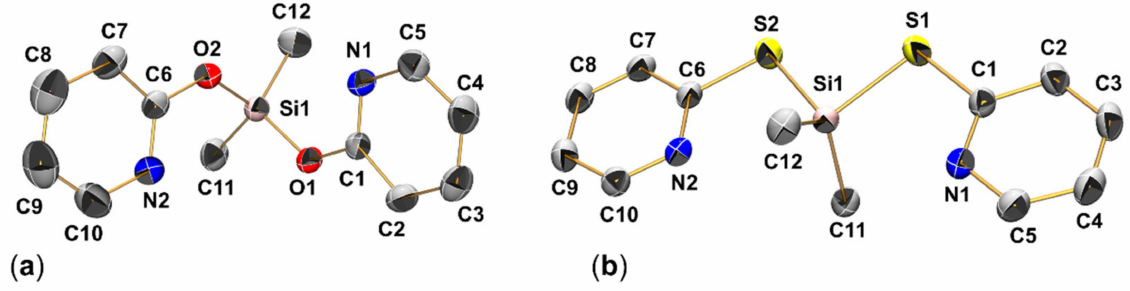
Figure 5. Molecular structures of ( a ) Me 2 Si(pyO) 2 ( 2a ) and ( b ) Me 2 Si(pyS) 2 ( 2b ) in the crystal with thermal displacement ellipsoids at the 50% probability level and atom labels. For the sake of clarity, the H atoms are omitted from the graphic. In both cases, the asymmetric unit comprises two individual (but conformationally very similar) molecules. For each compound, only one of them is depicted as a representative example. Selected interatomic distances (Å) and angles (deg.) of 2a : Si1-O1 1.657(2),